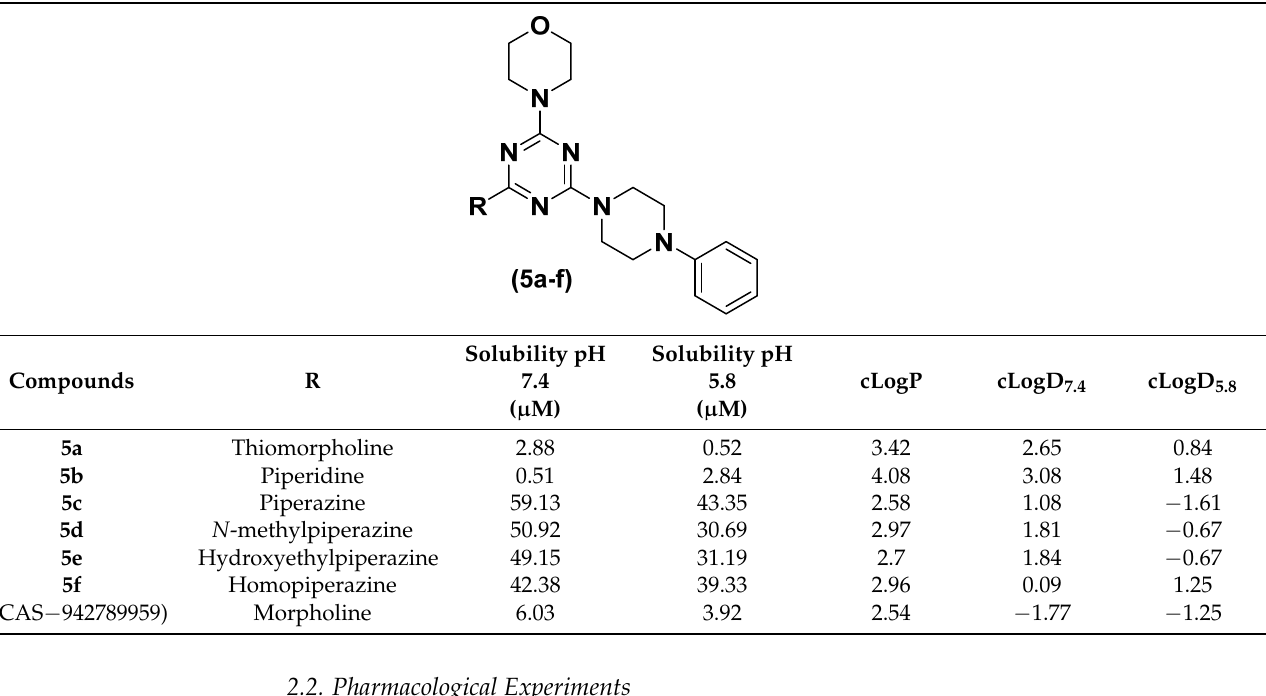
Table 1. pH-dependent aqueous solubility of compounds 5a-f and their cLogP and cLogD values.